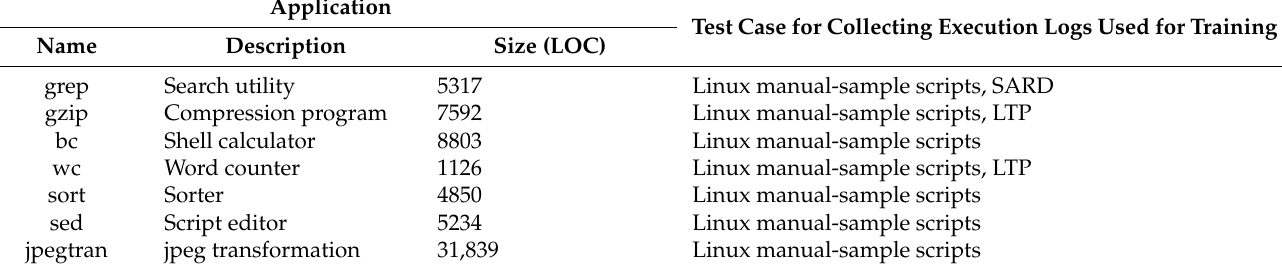
Table 2. Target applications considered in the experiments.